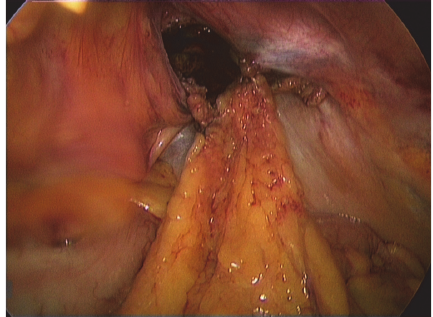
Figure 4: Omental patch was secured with minimal tension in the opening of the cystic